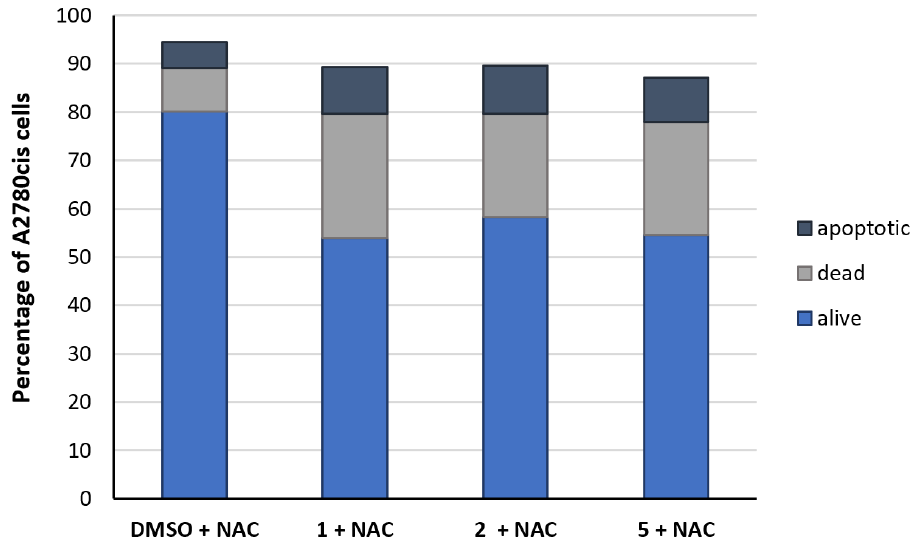
Figure 8. Differentiation of the A2780cis cell population (%) into apoptotic (dark blue), dead (grey), and alive cells (blue) after incubation for 24 h with NAC (1 mM), without compound (neg. control, DMSO), and with 1 , 2 , and 5 (1 µ M). Data are expressed as mean of two experiments.